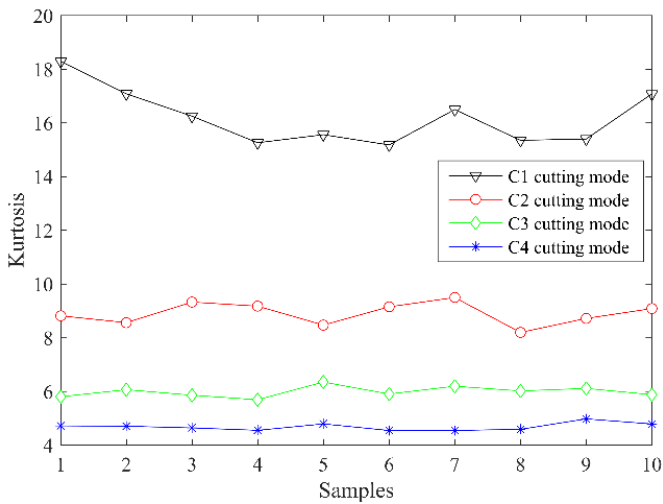
Figure 14. Kurtosis of cutting vibration signal.